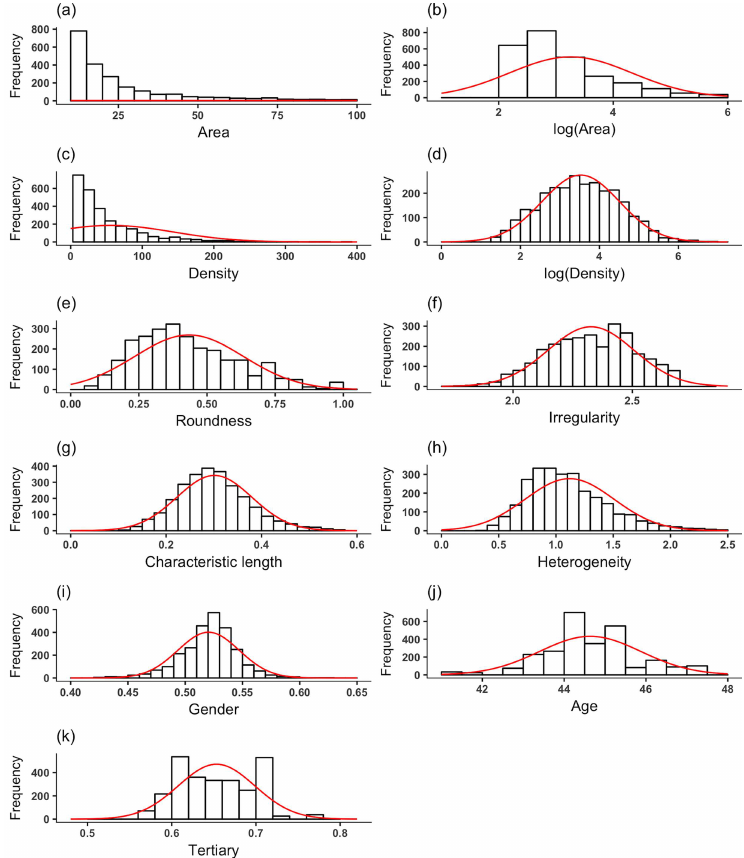
Fig 3. Distributions of the independent variables. (a) Area . (b) log( Area ). (c) Density . (d) log( Density ). (e) Roundness . (f) Irregularity . (g) Characteristic length ( CL ). (h) Heterogeneity . (i) Gender . (j) Age . (k) Tertiary . The clusters whose Area was less than 10 were omitted from the calculation of the distributions. Some of the distributions are truncated for a visibility reason. The curve shown in each panel represents the normal distribution with the sample mean and standard deviation.